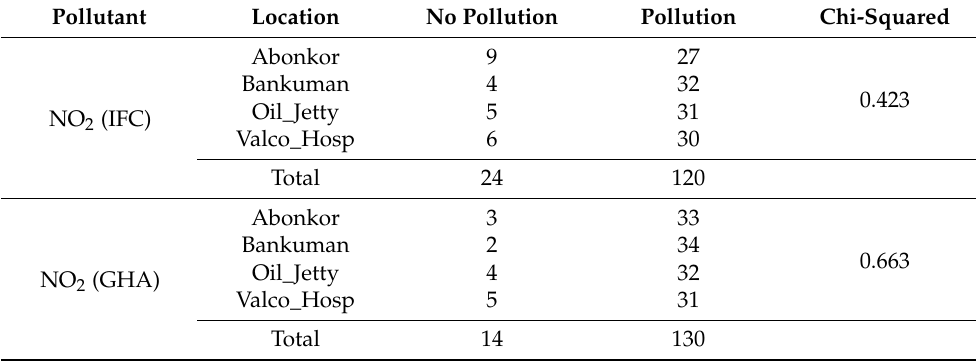
Table 1. NO 2 concentration across the four (4) locations.